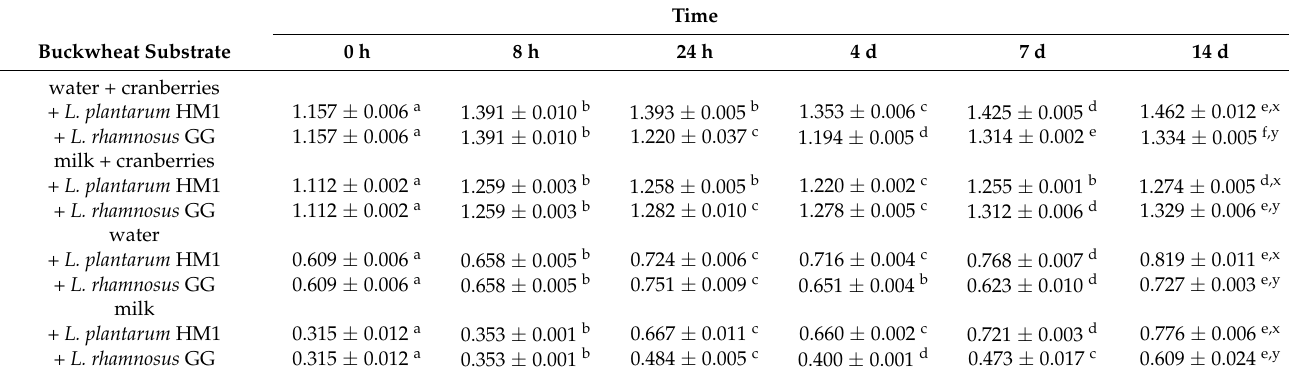
Table 5. Antioxidant activity of buckwheat mashes (mg DPPH/g) determined by DPPH